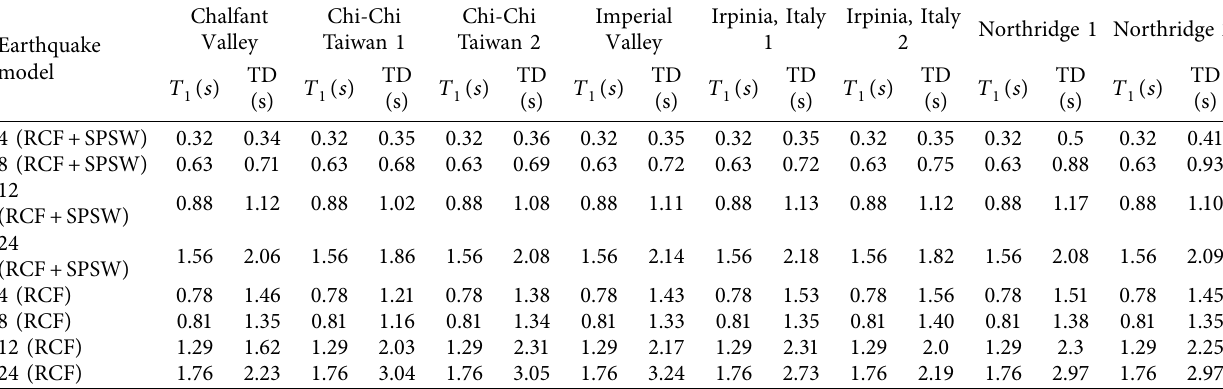
Table 7: Te frst-mode period of vibration and period of damaged of the models under Group II. Earthquake